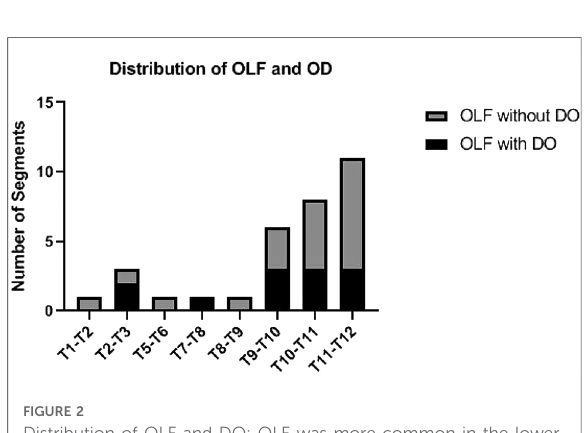
FIGURE 2 Distribution of OLF and DO: OLF was more common in the lower thoracic spine. More than half (75%) of the DO was located in T9- T12. DO, dural ossi fi cation; OLF, ossi fi cation of ligamentum fl avum.